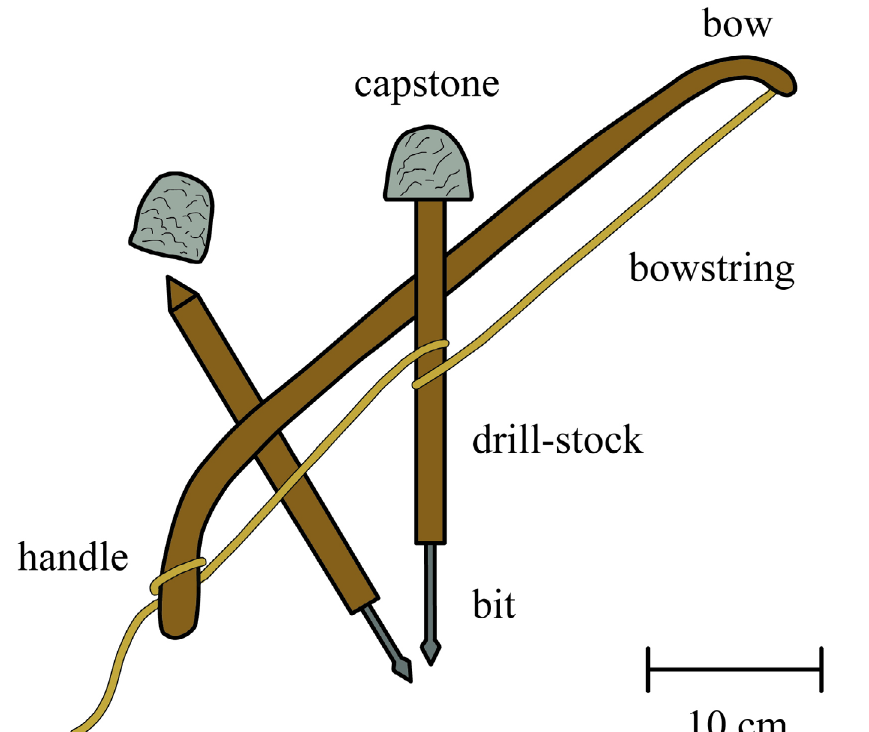
Figure 1. The components of a bow drill (after Wilkinson 1878: fig. 171).